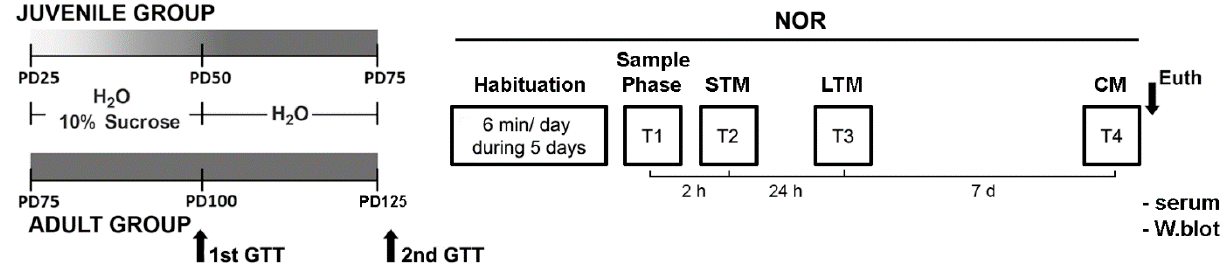
Figure 1. Time line of experimental procedures. The transition zone (soft gray) represents the early youth transition to adulthood (solid color). Over a 25 day period, 25 day old rats (juvenile group) and 75 day old rats (adult group) had unrestricted access to tap water (control group) or the choice to drink a 10% sucrose solution ( w / v made up of tap water, sucrose group) ad libitum. After this period, animals were subjected to GTT and continued to drink only water for other 25 days. Animals were then subjected to NOR and a second GTT. During NOR studies, animals were allowed to explore the objects for 6 min in all the sessions. STM, short term memory (T2); LTM, long term memory (T3); and CM, consolidated memory (T4). The schematic diagram shows the sequential order of the memory task. After NOR, 5 animals were randomly assigned for Western blot (W. blot).